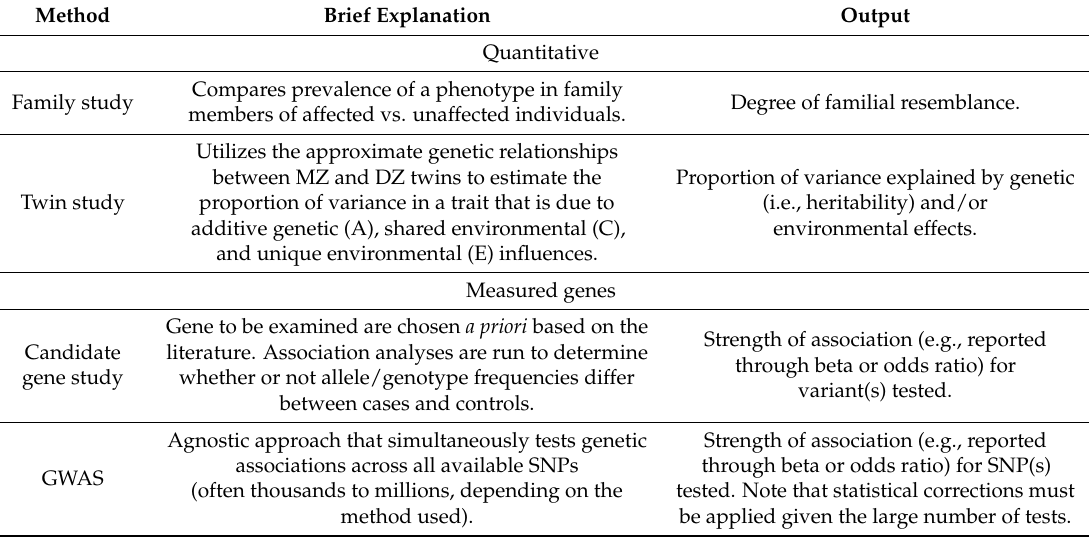
Table 1. Overview of genetic methodology used within the insomnia